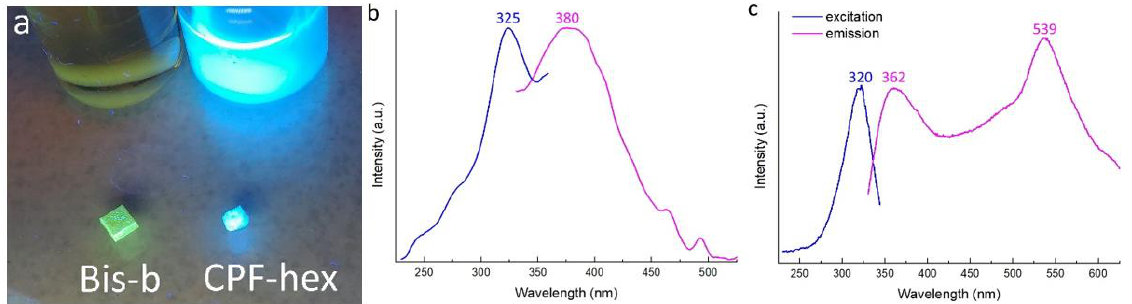
Figure 6. ( a ): The photocurable resins and the scaffolds under UV-LED 365 nm. The fluorescence spectra of the scaffolds with CPF-hex ( b ) and Bis-b ( c ).